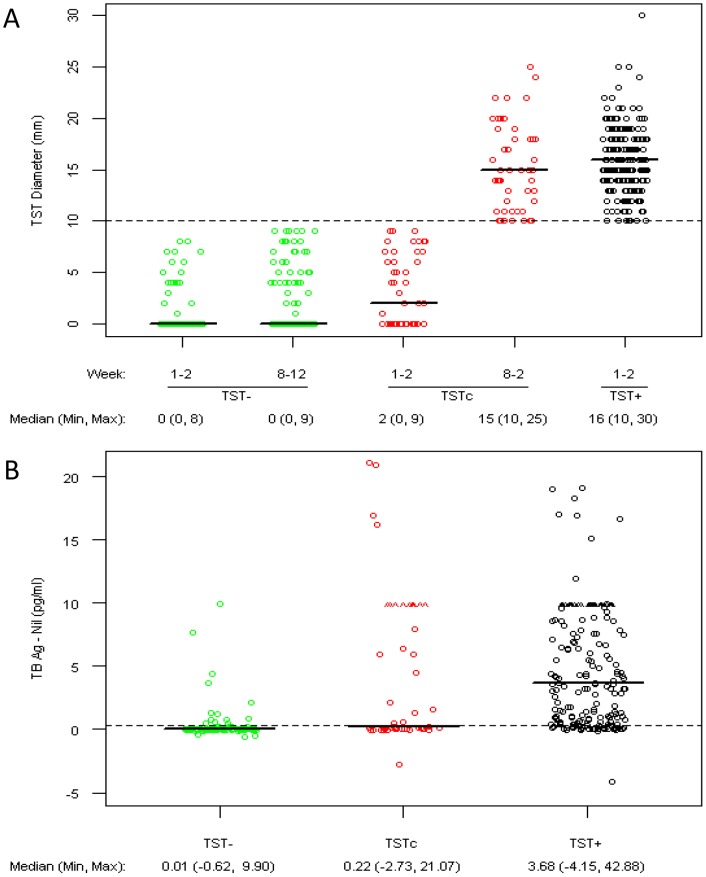
Comparison of the magnitude of TST and IGRA responses.A) PPD Diameter for 1st and 2nd TST in TST-negative (TST-), TST-converter (TSTc), and Prevalent TST positive (TST+) groups displayed by PPD testing visit and TST group*. B) IGRA results using Quantiferon Gold In-tube quantitative TB Ag – Nil by TST-, TSTc, and TST+ groups. 2nd TST is only performed when PPD diameter in TST1 is <10 mm. Dashed line in Figure 2A at 10 mm is the cutoff for a positive TST result. ∧ indicates values greater than 10 IU/ml (prior to December 2009 levels ≥10 IU/ml were reported as 10+). A dashed line in Figure 2B is shown at 0.35 IU/ml, the cutoff for a positive IGRA test result.